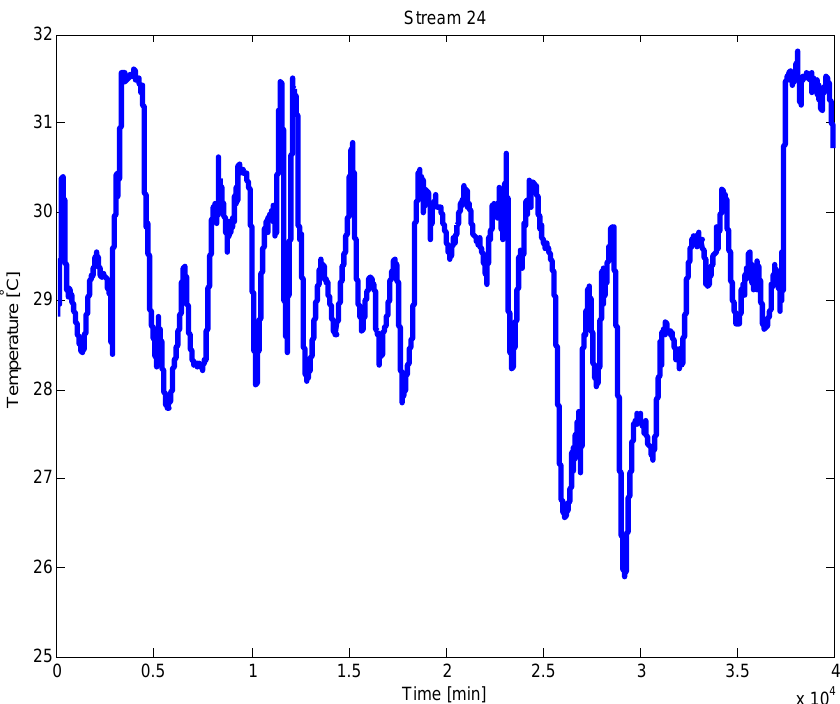
Figure 6. Temperature experimental data of Stream 24 for a month period.